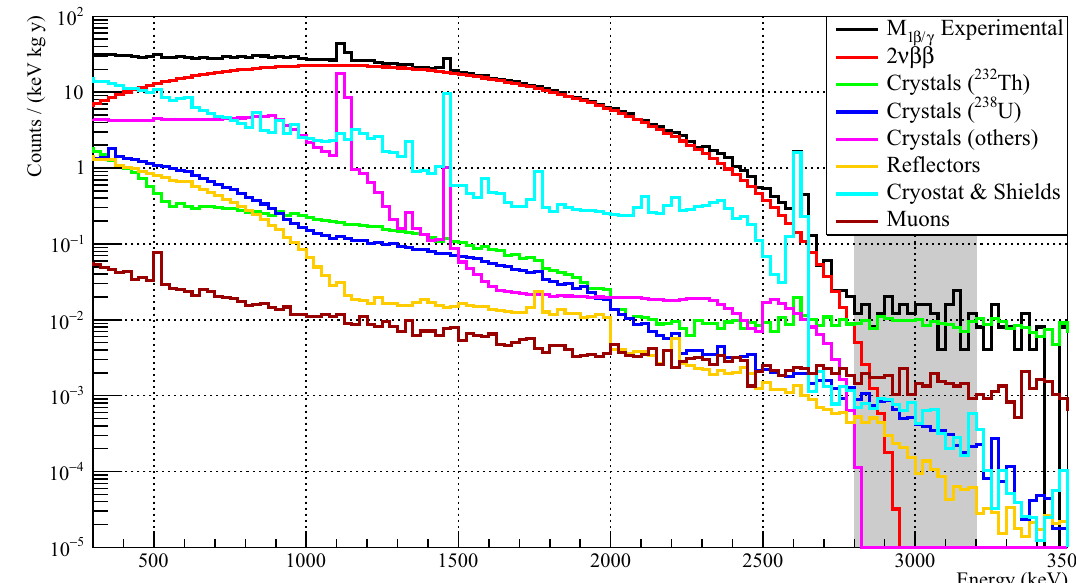
Fig. 9 Background sources contributing to the M 1 β/γ reconstruction, grouped by source and component. The shaded area corresponds to the 400 keV energy range from 2.8 to 3.2 MeV (ROI bkg ) chosen to analyze the background in the region of interest around the 82 Se 0 νββ Q-value.